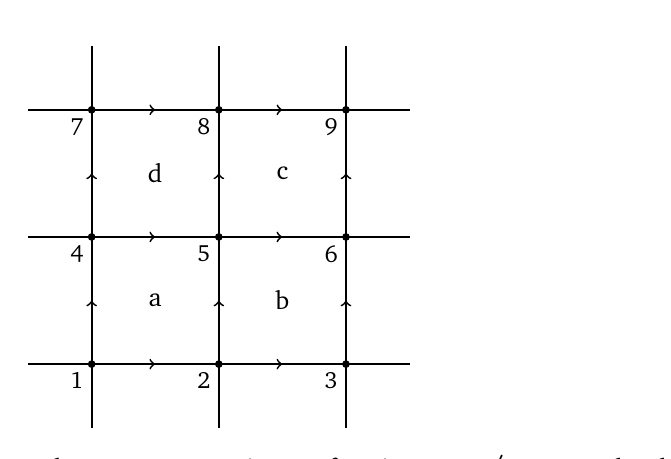
, γ ′ . For each edge, f f , Y , Z e e e